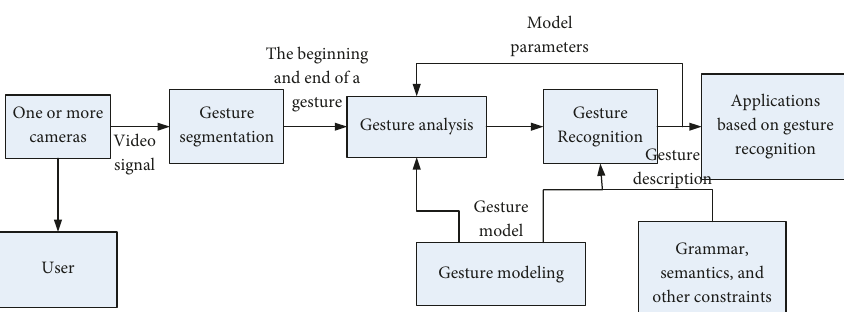
Figure 3: Overall design of dynamic gesture recognition system based on image processing.